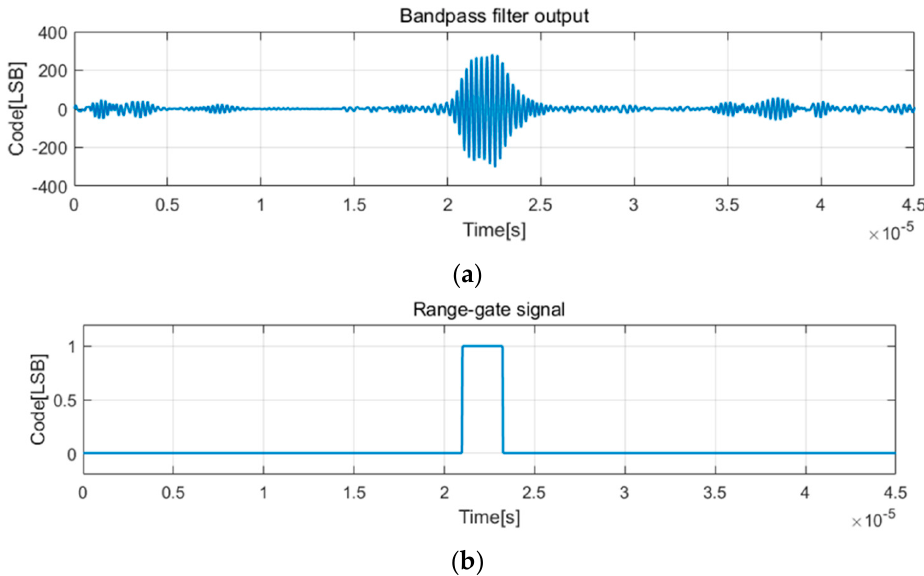
Figure 18. Measured ( a ) band-pass filter output for accumulated ensemble differences, and ( b ) Range-gate signal from the flow phantom model.